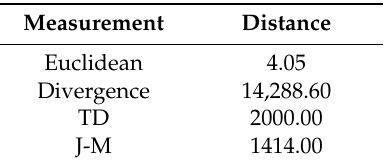
Table 2. Various spectral distance measurements between tea and non-tea (including non-tea LULC, forest, water and ponds, buildings and roads) training